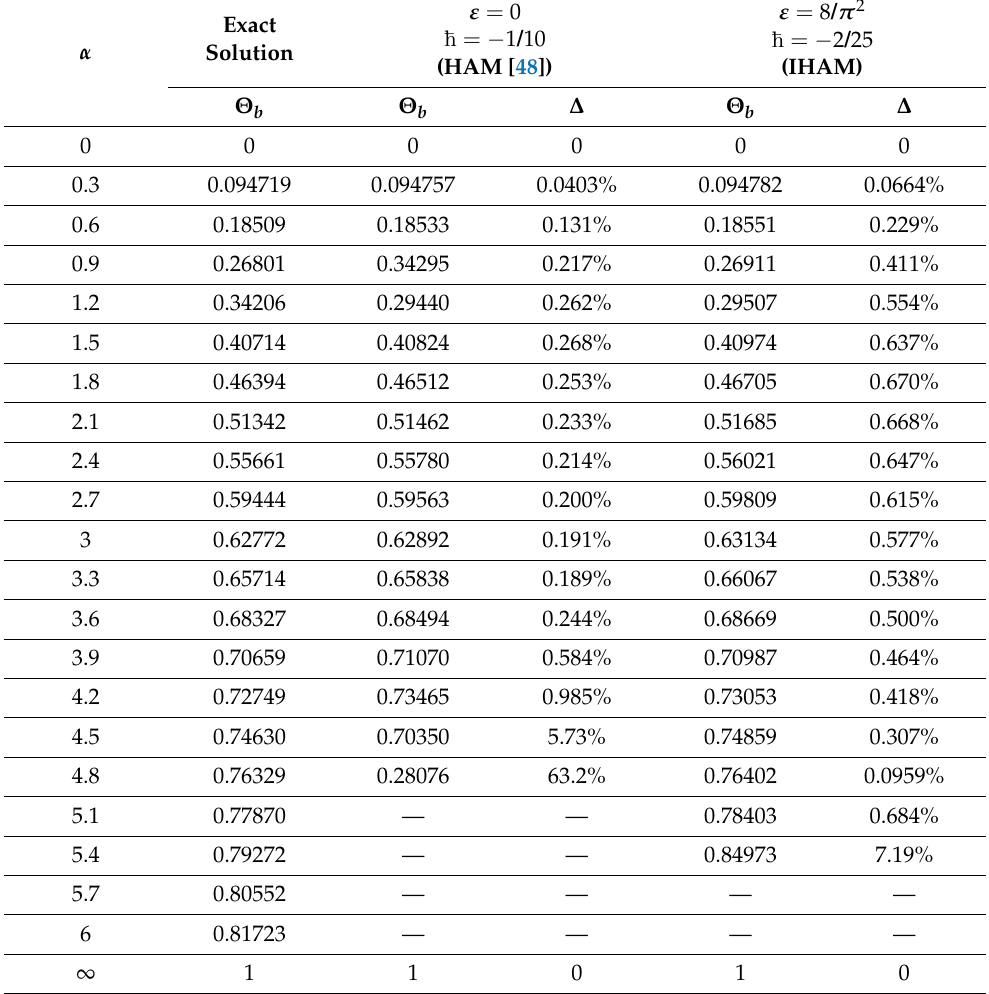
[ n = 30 ] by IHAM and b